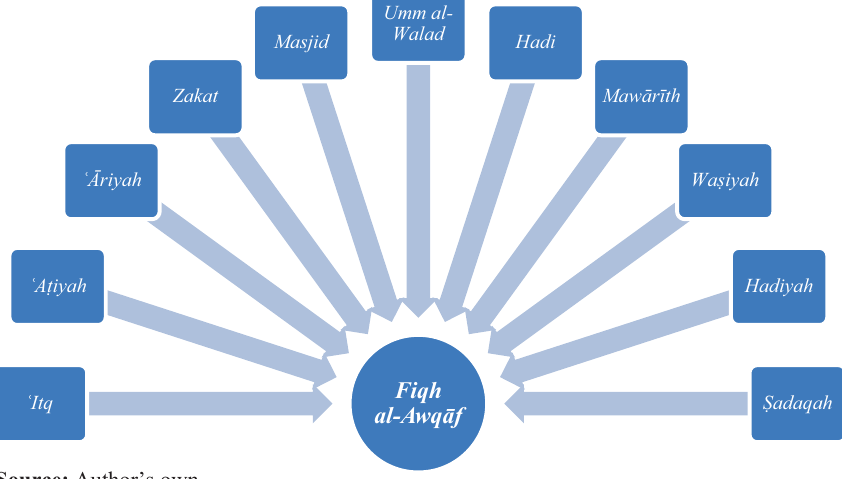
Figure 2. Tools of qiy (cid:1) as ( maq ī